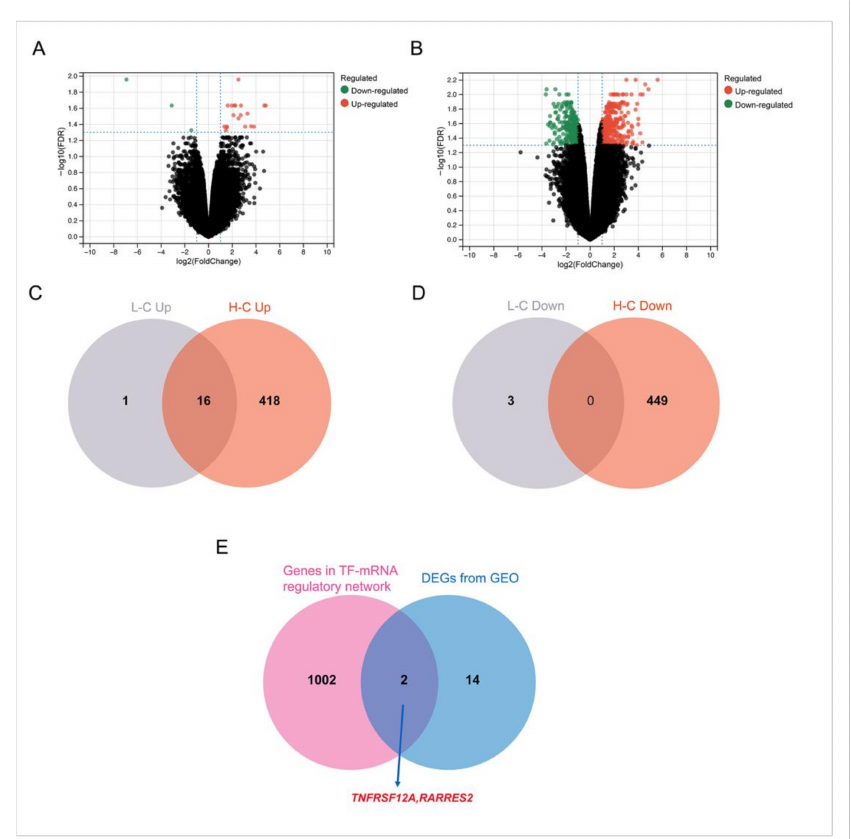
Figure 5. Combined analysis with rat lung injury models. ( A , B ): Volcano plots of significantly changed genes in rat lung tissues with acute pulmonary embolism induced by polystyrene micro- spheres of diverse concentrations. ( A ) low-dose group vs control group and ( B ) high-dose group vs control group). ( C , D ): Up-regulated genes ( C ) and down-regulated genes ( D ) with consistent trend in two concentrations of polystyrene treated groups. “L-C” denotes low-dose group vs control group, and “H-C” denotes high-dose group vs control group. ( E ) overlap of DEGs from our RNA-seq and GEO